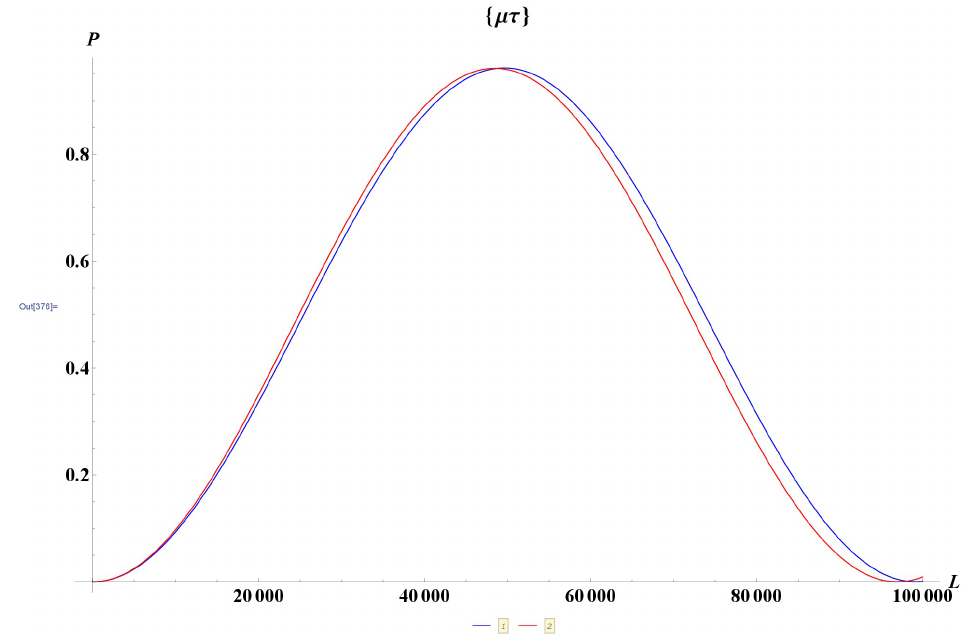
Figure 6. Same of Figure 5 in the case of the oscillation probability P ν